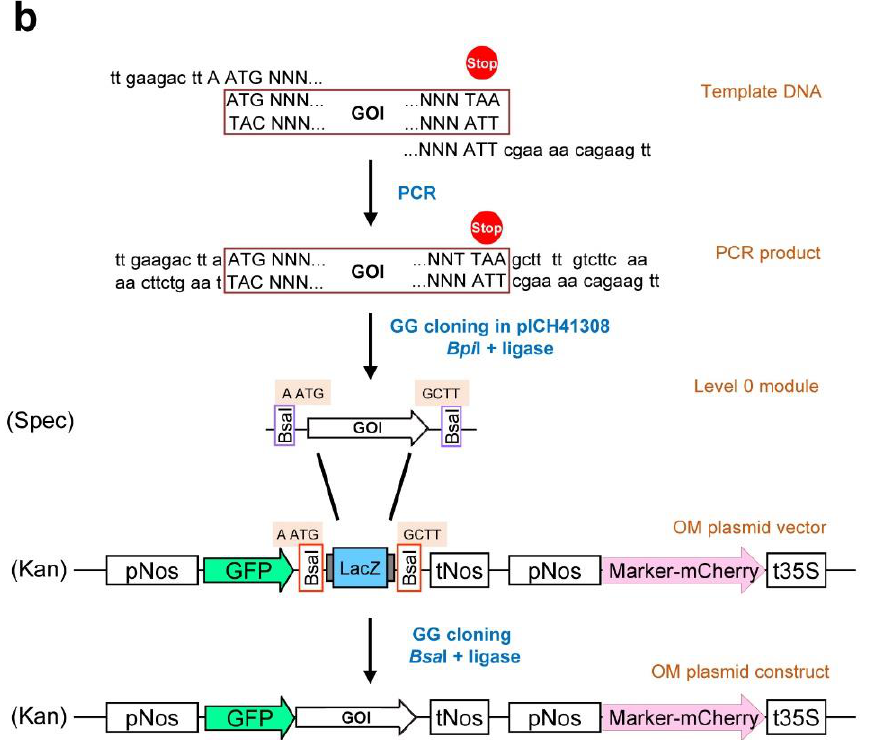
Figure 1. Cloning strategy to obtain protein of interest (POI)–GFP fusions in vectors containing organelle markers (OM). ( a ) C-terminal fusion of POI with GFP. ( b ) N-terminal fusion of POI with GFP. The coding sequence of the POI (GOI) obtained by PCR and extended by the Bpi I-recognition sites has to be cloned into level 1 vector pAGM1287 or pICH41308 depending on the envisaged N- or C-terminal fusion with GFP, respectively. As second step, Bsa I has to be used to transfer the gene of interest into the final level 2 vector containing the coding sequence of GFP and the selected OM. ns = no stop.